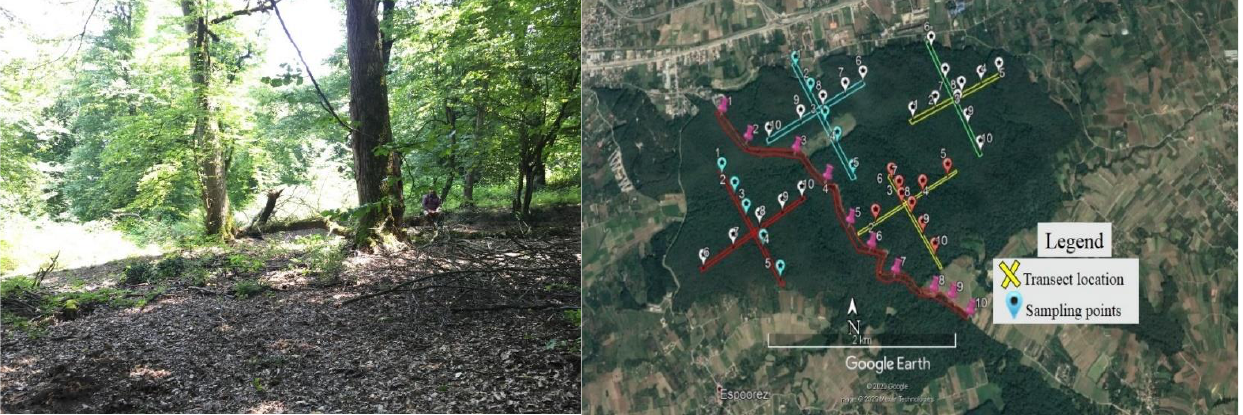
Figure 2. A view of the sampling area and natural forests.